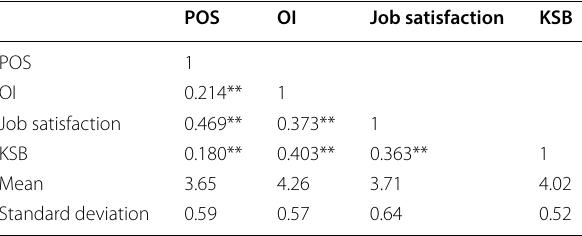
Table 1 Correlations, mean and standard